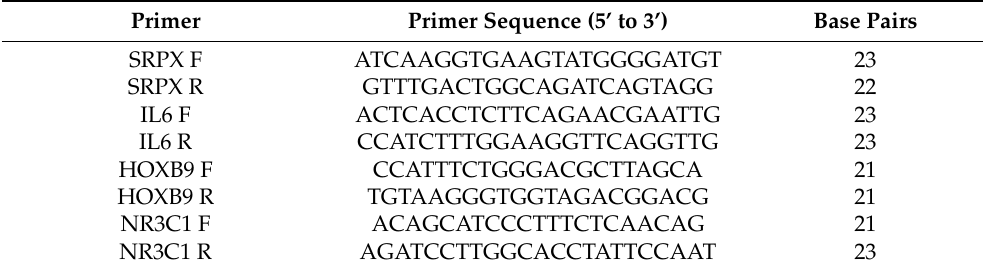
Table 3. PCR results of four hypoxia-related genes in the EC prognostic model. Primer Primer Sequence (5’ to 3’) Base